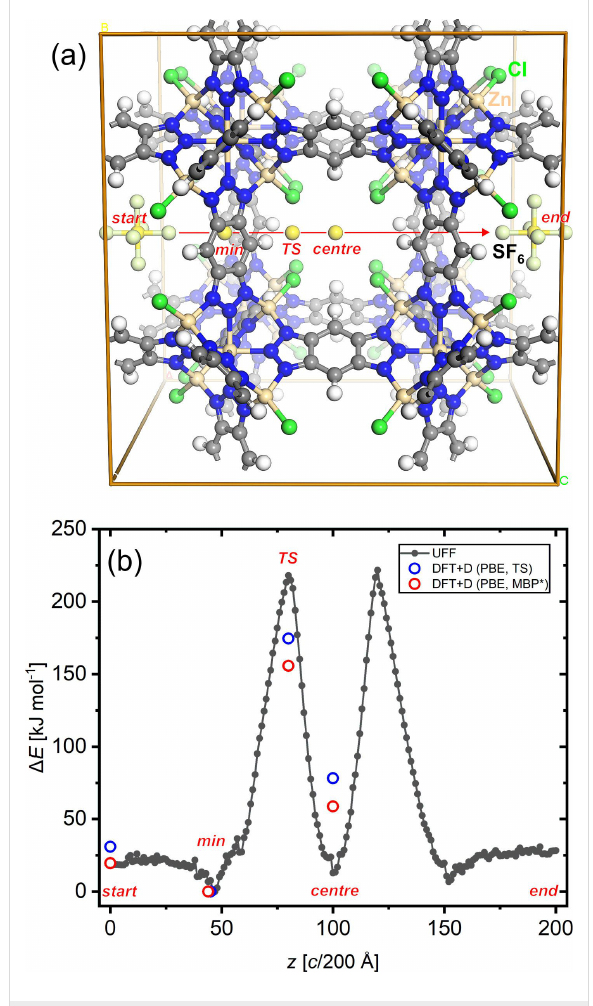
Figure 5: (a) MFU-4 unit cell showing the linear transition scan path for SF 6 crossing a single small pore. (b) Black curve and filled circles: differences of UFF total energy values of 200 configurations of SF 6 @MFU-4 scanned along the linear path displayed in (a). Open circles: differences of DFT total energy values for selected configura- tions and different dispersion correction methods (for explanations see